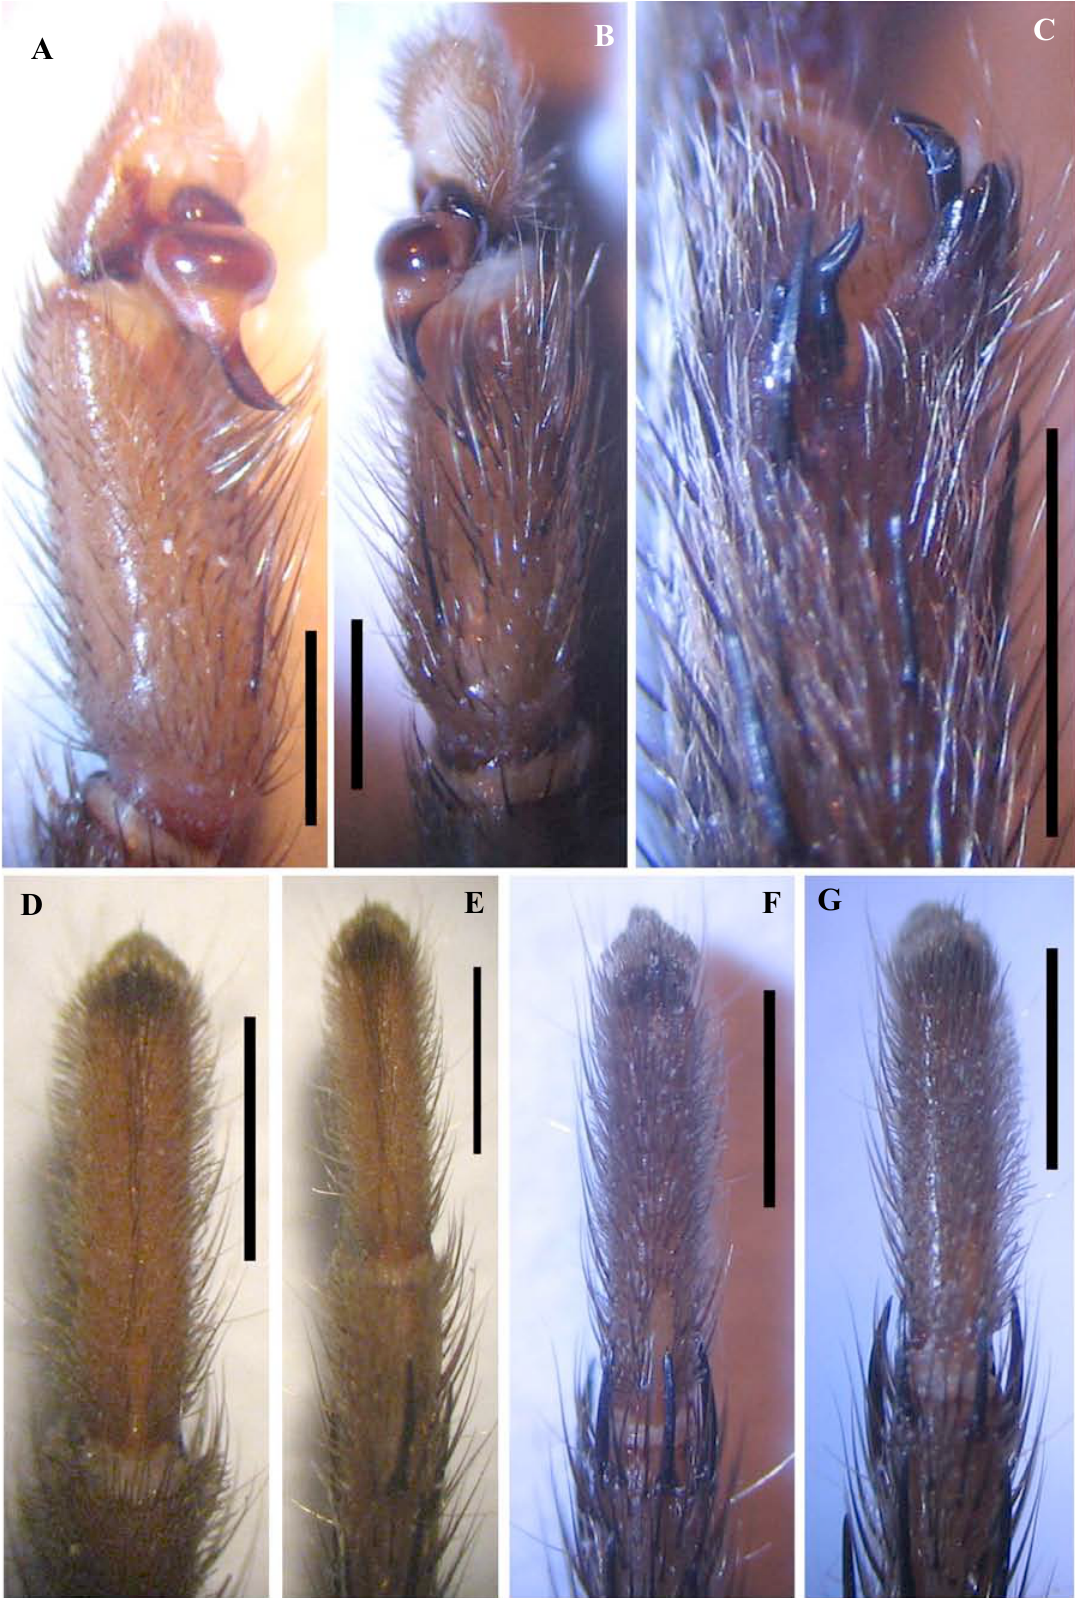
Figure 6. S. arthrapophysis male. A. Palp, retrolateral view. B. Palp, prolateral view. C. Tibial spurs. D−G. Leg tarsus (I−IV), ventral view showing divided scopulae. (Scale